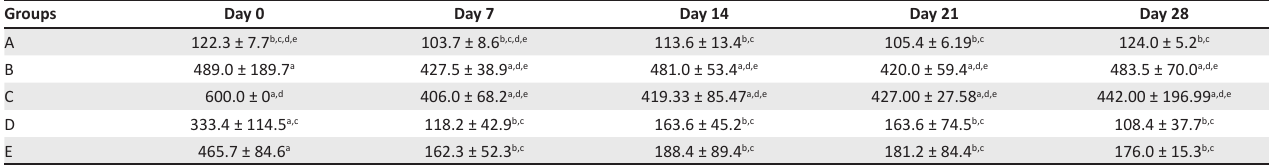
TABLE 1: Effect of Vernonia amygdalina on blood glucose (mg/dL) of alloxan-induced diabetic rats. Groups